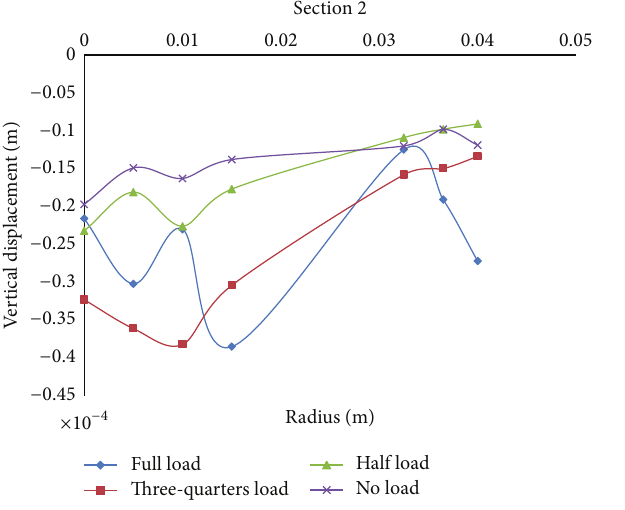
Figure 16: Variation in radial stresses at section 2.